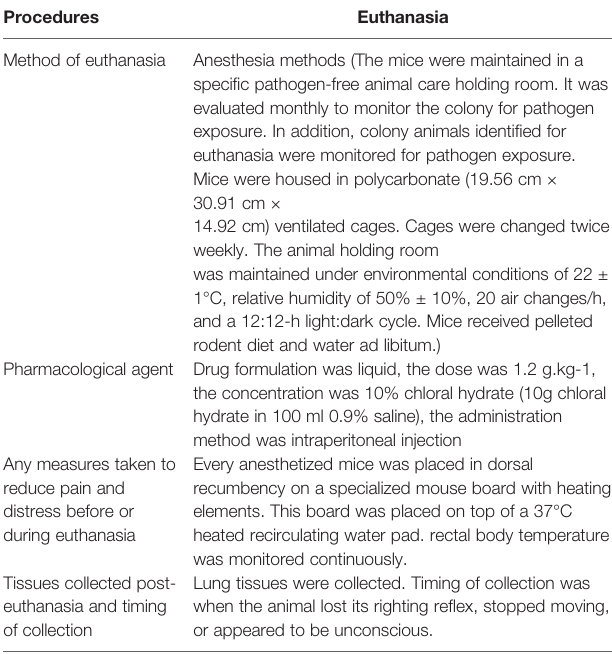
TABLE 2 | Arrive-guidelines of